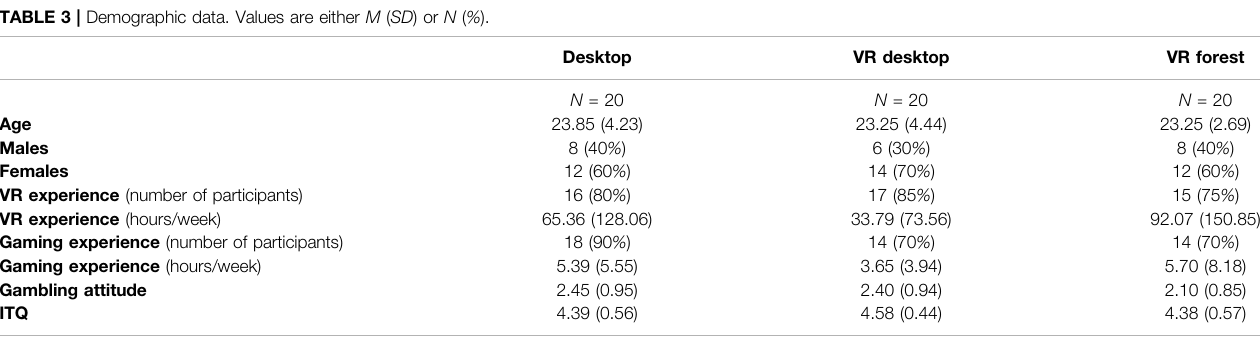
TABLE 3 | Demographic data. Values are either M ( SD ) or N ( % ).